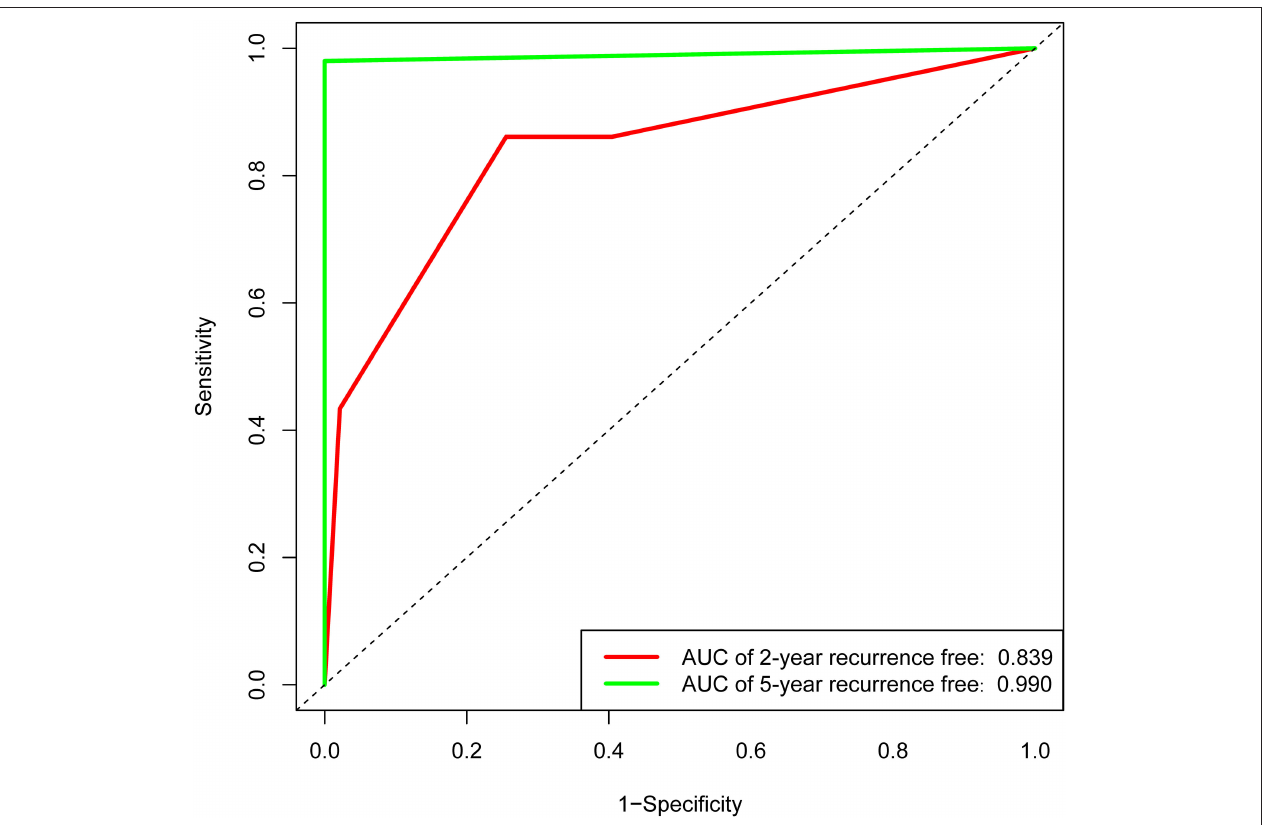
FIGURE 7 | Receiver operating characteristic curve of the nomogram 1 in the validation set. The red line represents 2-year recurrence-free rate. The green line represents 5-year recurrence-free rate.